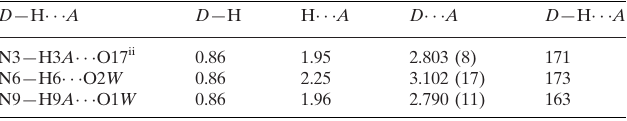
Hydrogen-bond geometry (A˚ , (cid:4)